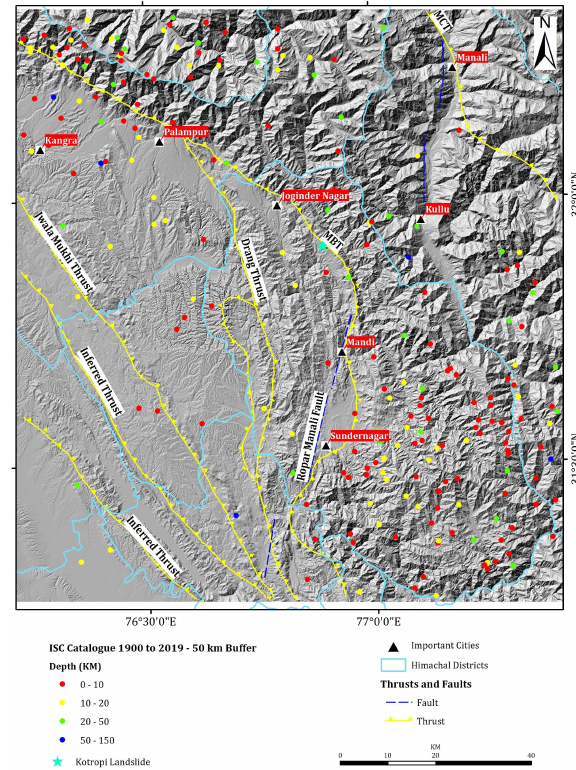
Figure 2. Ropar-Manali fault that passes through the Kotrupi landslide location. The earthquake epicenters within 50 km buffer zone of study area has been marked. The main boundary thrust (MBT) and Main central Thrust (MCT) is marked in the map (Modified after (Thakur et al.,